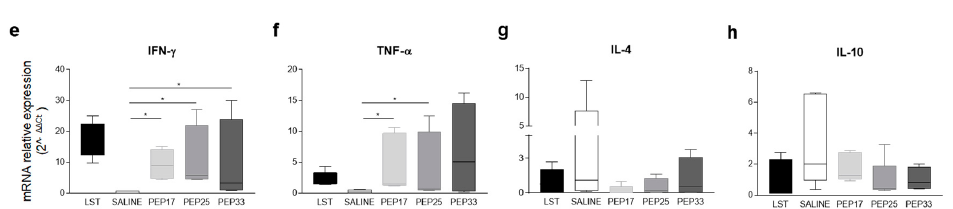
Figure 2. Cellular immune responses in dogs after inoculation with synthetic peptides. Naturally infected asymptomatic dogs ( n = 5) were inoculated with 50 µ g of synthetic peptides, and erythema and induration were measured 48 hours after injection. ( a ) Schematic and representative design of the reverse antigen screening approach by intradermal injection of saline, Leishmanin skin test (LST) and peptides in naturally infected dogs. ( b ) Erythema diameter with absence (o) and presence ( ● ) of induration 48 h after injections. ( c ) Morphometric analysis of the inflammatory process for LST, saline, peptide 17 (PEP17), peptide 25 (PEP25), and peptide 33 (PEP33). ( d ) Representative Hematoxylin and eosin stains of biopsies taken from inoculums sites 48 h after LST (I), saline (II), PEP17 (III), PEP25 (IV), and PEP33 (V), black bar = 50 µ m. ( e – h ) Box plots representing reverse-transcriptase quantitative PCR of mRNA expression for IFN- γ ( e ), TNF- α ( f ), IL-4 ( g ) and IL-10 ( h ) at the inoculum sites of LST, saline, PEP17, PEP25, and PEP33 injections. LST was not used for statistical analyses. The p values represent the di ff erence between the groups saline, PEP17, PEP25, and PEP33: * p- value < 0.05, *** p- value < 0.0005.